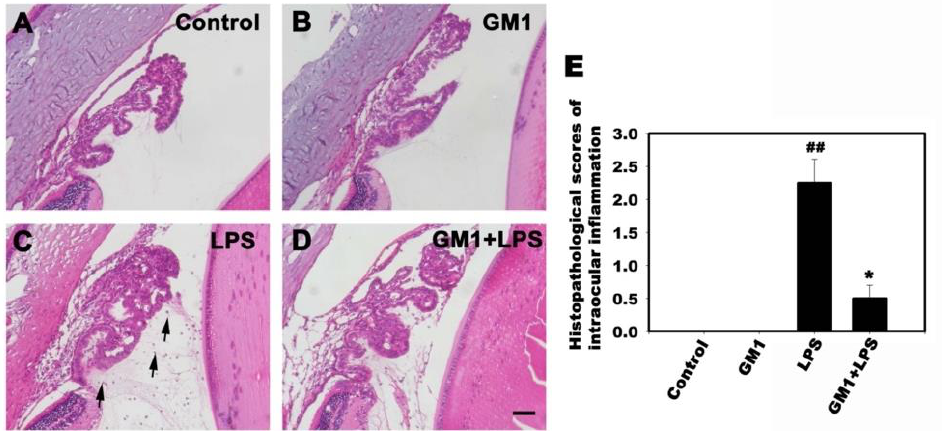
Figure 3. Effects of GM1 on the histological changes in the ICB of rats with EIU. Rats were pretreated with GM1 and then treated with or without LPS for another 24 hours. Representative images of H&E staining of the ICB from the four different treatment groups: vehicle control ( A ), GM1 alone ( B ), LPS ( C ) and GM1+LPS ( D ). The LPS-treated rats showed increased leukocyte infiltration in the ICB and the AqH (arrows in C), whereas the number of infiltrating cells was reduced by GM1. ( E ) The severity of histological changes was evaluated by histopathological scoring with a scale ranging from 0 to 3. GM1 significantly attenuated LPS-induced pathological scores in the ICB. ## p < 0.01 compared with the control group; * p < 0.05 compared with the LPS-treated group. Bar = 50 µ m. ICB: iris-ciliary body. AqH: aqueous humor.